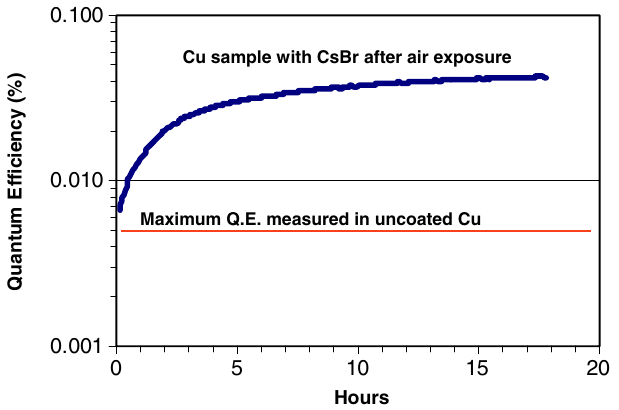
FIG. 3. (Color) Quantum efficiency (%) of CsBr = Cu exposed to air for 1 min and baked at 140 C. The sample was illuminated at 4 : 8 W = cm 2 with a 257 nm laser. The maximum quantum effi- ciency observed in an uncoated Cu sample is also shown in the figure.